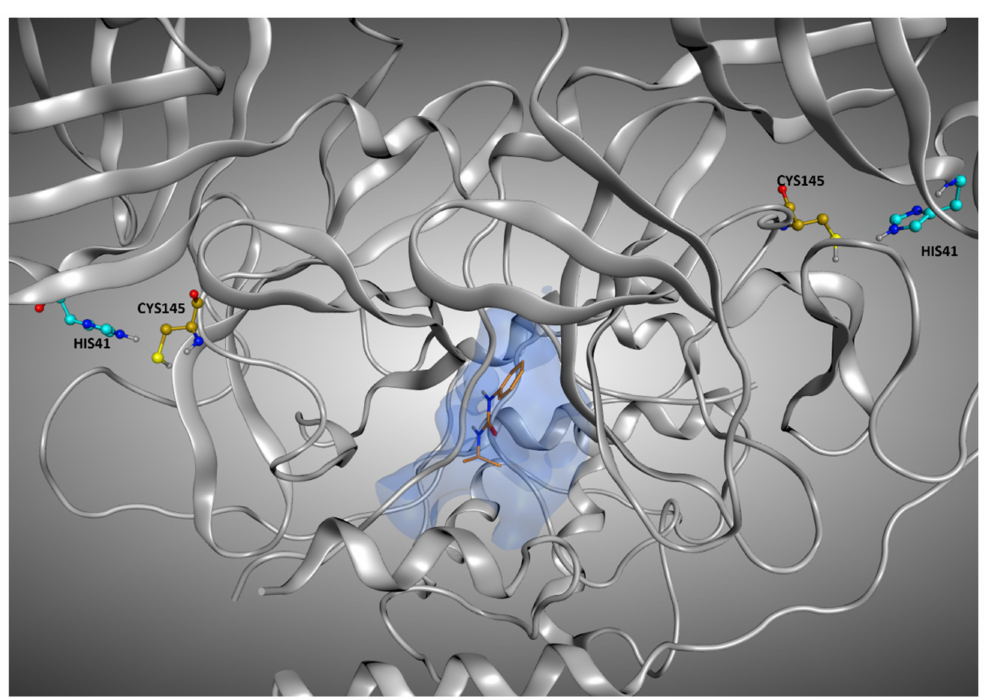
Figure 12. Representation of the crystallographic pose of 7LFP, which is one of the protein–ligand complexes in which, even if the crystallographic ligand is located outside the orthosteric binding site, the RMSD values between the original coordinates and the ones given from the docking runs are considerably low. The reason for this can be found in the very low solvent exposure of this ligand, which is located in the interface between the monomers, and so is shielded by them. The ligand is represented in orange, and the catalytic dyad (Cys145 and His41) of both monomers is highlighted. To give a better representation, the surface of the protein in a 5 Å radius from the ligand is represented and colored in